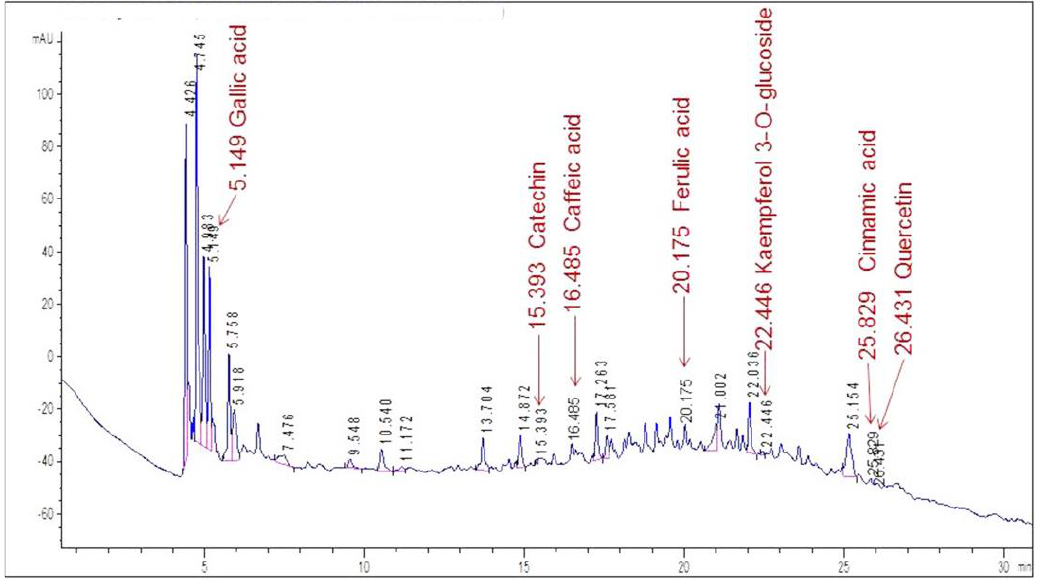
Figure 3. HPLC/DAD profile of the VE aqueous extract of X. caeruleum leaves. Labels indicate the retention time for each identified compound.